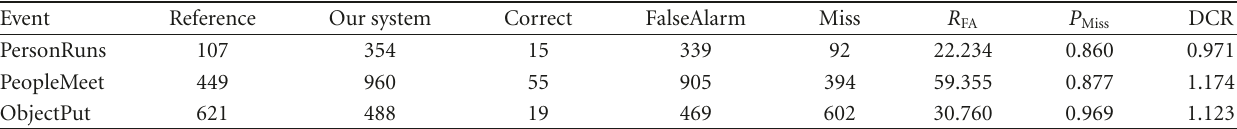
Table 4: Results in TRECVID 2009 event detection task.